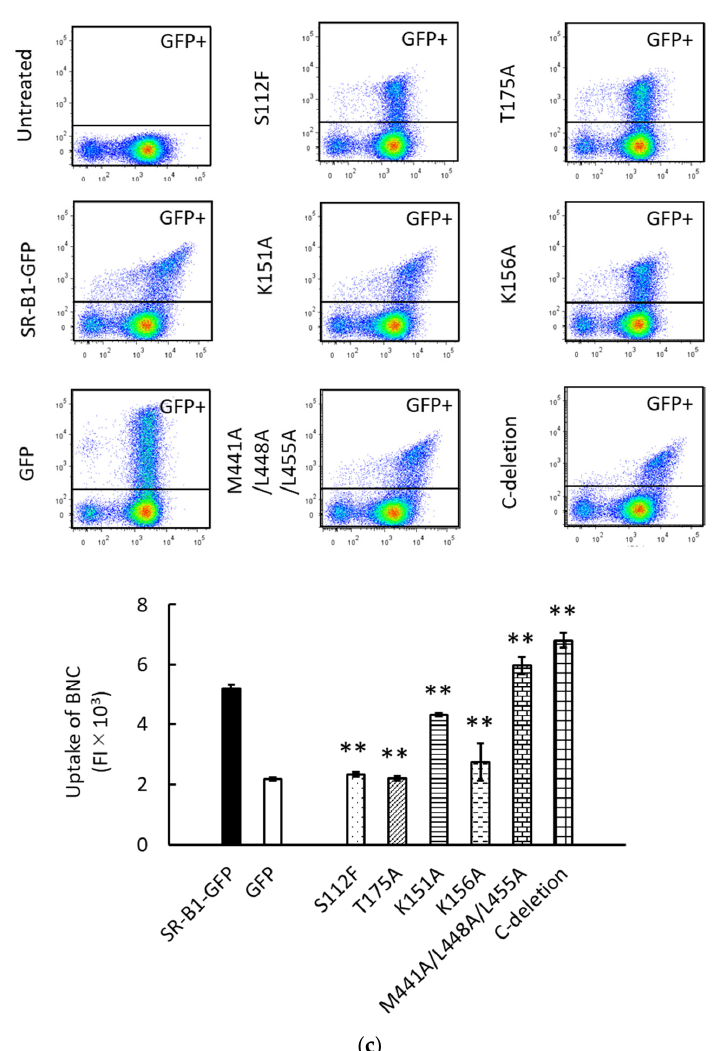
Figure 3. The interaction of BNCs and mutated SR-B1-GFP expressed in HEK293T cells. ( a ) Schematic illustration of mutagenesis induced in SR-B1-GFP. Mutated sites in SR-B1 (462 a.a.) are indicated as vertical black stripes. GFP is fused to the C-terminus of SR-B1. ( b ) Binding of CV-BNCs to HEK293T cells expressing mutated SR-B1-GFP. BNC binding assays using flow cytometry were conducted 24 h after plasmids to express SR-B1-GFP and its mutants were transfected into HEK293T cells. The vertical and horizontal axes of two-parameter dot plots indicate FI of GFP and CV, respectively. The bar graph shows the binding of CV-BNCs to the GFP+ subset (i.e., the upper gated area of dot plots) of plasmid-transfected cells. In triplicate assays, statistical analysis was done between cells expressing the wild type and mutated SR-B1-GFP. ( c ) Uptake of BNCs by HEK293T cells expressing mutated SR-B1-GFP. Cells were cultured for 18 h in the presence of CV-BNCs (5 µg/mL) 6 h after they were transfected with plasmids. Trypsinized cells were then subjected to flow cytometry. Data are shown in the same manner as ( b ). In bar graphs, data were expressed as means ± standard errors (vertical bars) in triplicate assays. Statistical analysis was performed using Student’s t -test between HEK293T cells transfected with plasmids to express authentic SR-B1-GFP and mutants; * and ** indicate p < 0.05 and p < 0.01, respectively.